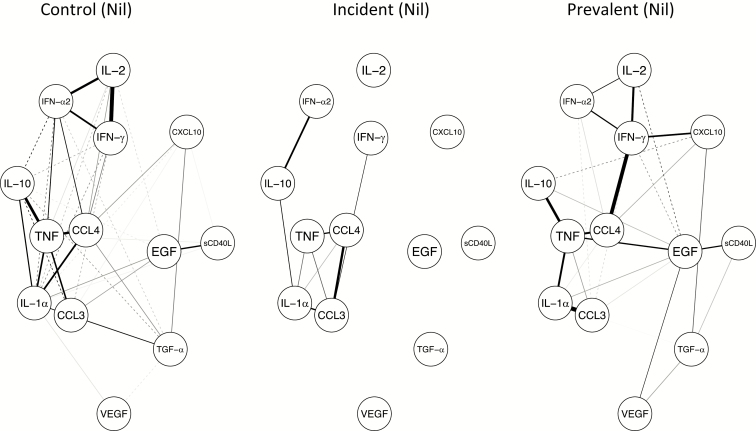
Weighted correlation networks in (left to right) controls, incident, and prevalent tuberculosis groups. Solid lines are indicative of positive correlations, dashed lines indicate negative correlations, and the strength of a correlation is indicated by the thickness of the line. Abbreviations: CCL, chemokine (C-C motif) ligand; CXCL10, C-X-C motif chemokine 10; EGF, epidermal growth factor; IFN, interferon; IL, interleukin; sCD40L, soluble CD40 ligand; TGF-α, transforming growth factor-α; TNF, tumor necrosis factor; VEGF, vascular endothelial growth factor.